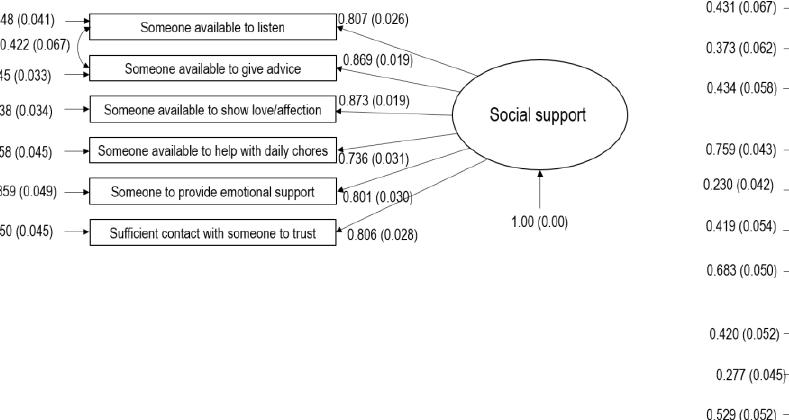
Figure 1. Measurement models in step one of Structural Equation Modeling procedure. Panel a shows final measurement model of social support; Panel b shows final measurement model for social and financial hardship. The displayed estimates are standardized coefficients (β) and standard error is displayed in parentheses.